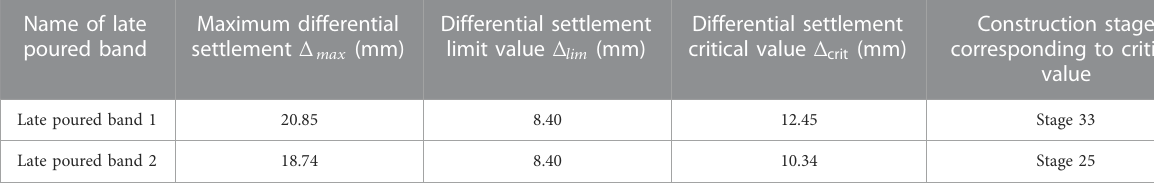
TABLE 5 Critical value of differential settlement for late poured band which is poured in advance. Name of late poured